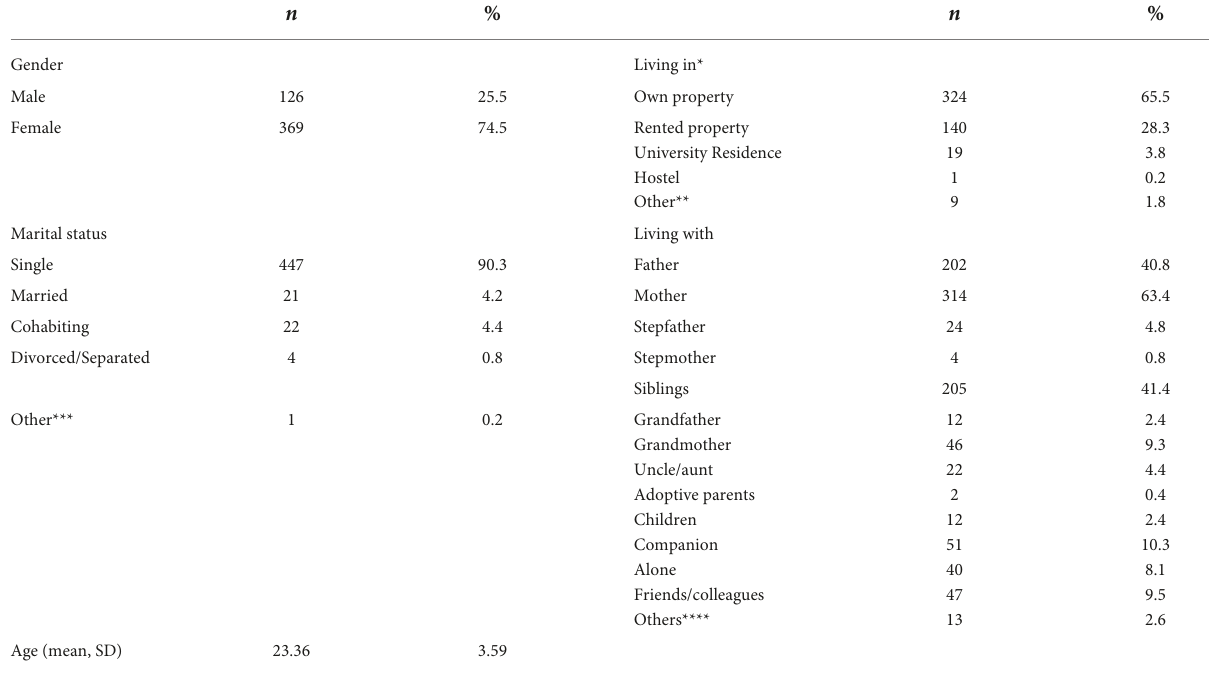
TABLE 1 Sociodemographic characteristics: Sex, marital status, age, residential status and who they lived with ( N = 495). n % n